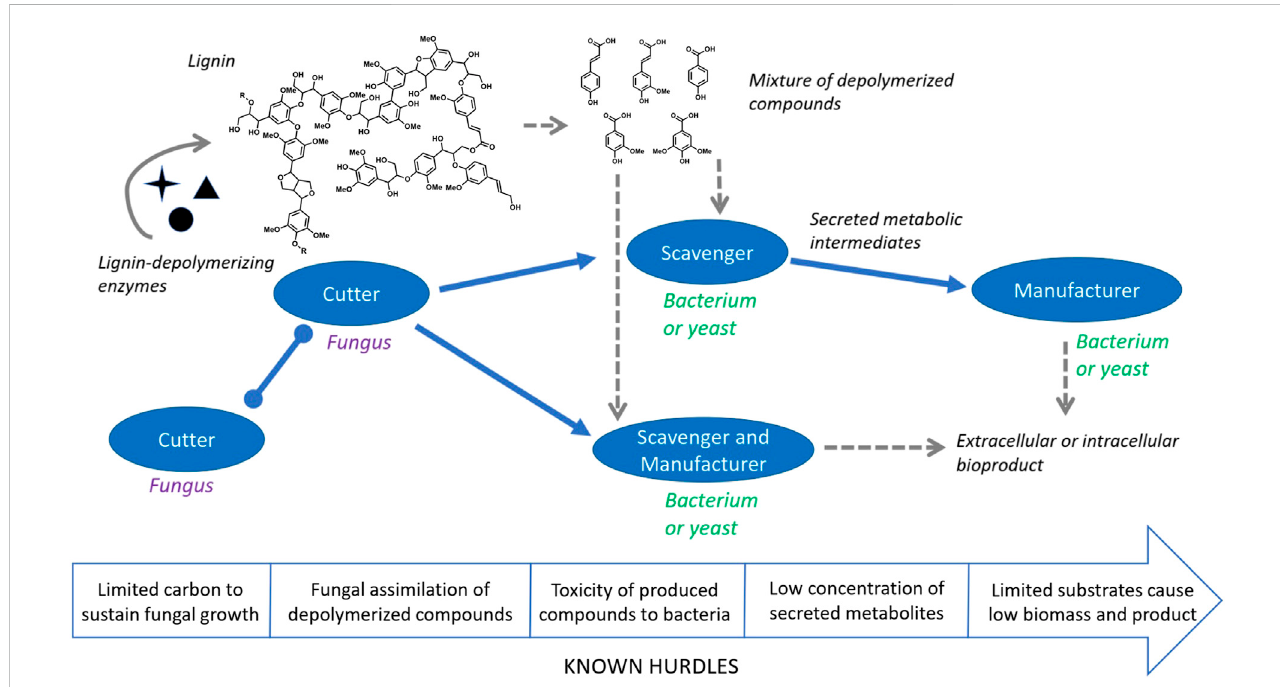
FIGURE 1 A concept for building a synthetic microbial community for conversion of lignin to valuable products. Cutters represent fungi that secrete lignin degrading enzymes, scavengers represent microbes that catabolize lignin fragments and potentially convert them to a shareable intermediate, and manufacturers represent engineered hosts that convert either lignin fragments or a shared intermediate to bioproducts. The arrow at the bottom depicts hurdles that may be present at various stages of the conversion